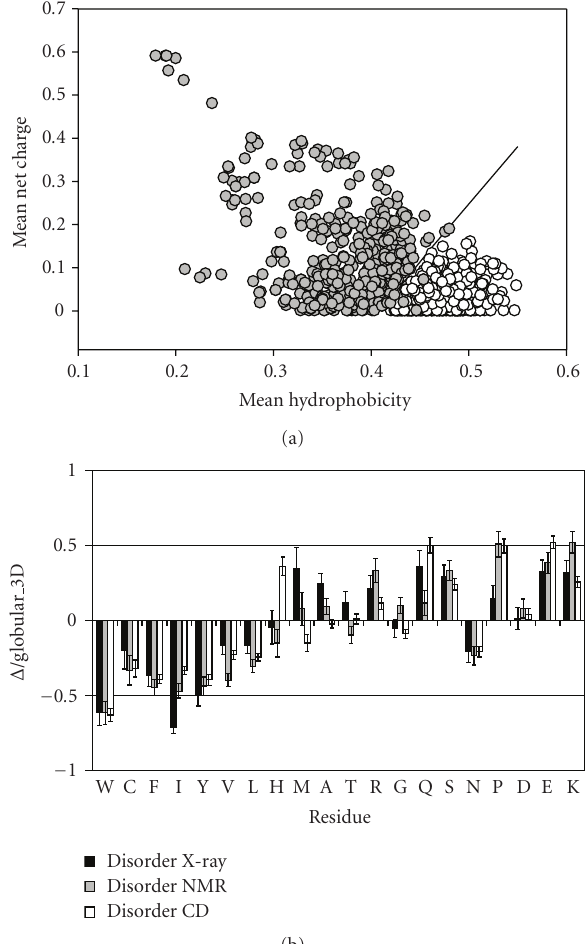
Figure 2: Peculiarities of amino acid composition of ID proteins . (a) Comparison of the mean net charge and the mean hydrophobicity for a set of 275 ordered (open circles) and 91 natively unfolded proteins (gray circles). The solid line represents the border between extended IDPs and ordered proteins (see text). (b) Order/disorder composition profile. Comparisons of amino acid compositions of ordered proteins with each of three databases of disordered proteins. The ordinates are (%amino acid in disordered dataset – %amino acid in ordered dataset)/(%amino acid in ordered dataset) = (cid:2) /globular 3D. Names of each database indicate how the disordered regions were identified. Negative values indicate that the disordered database has less than order, positive indicates more than